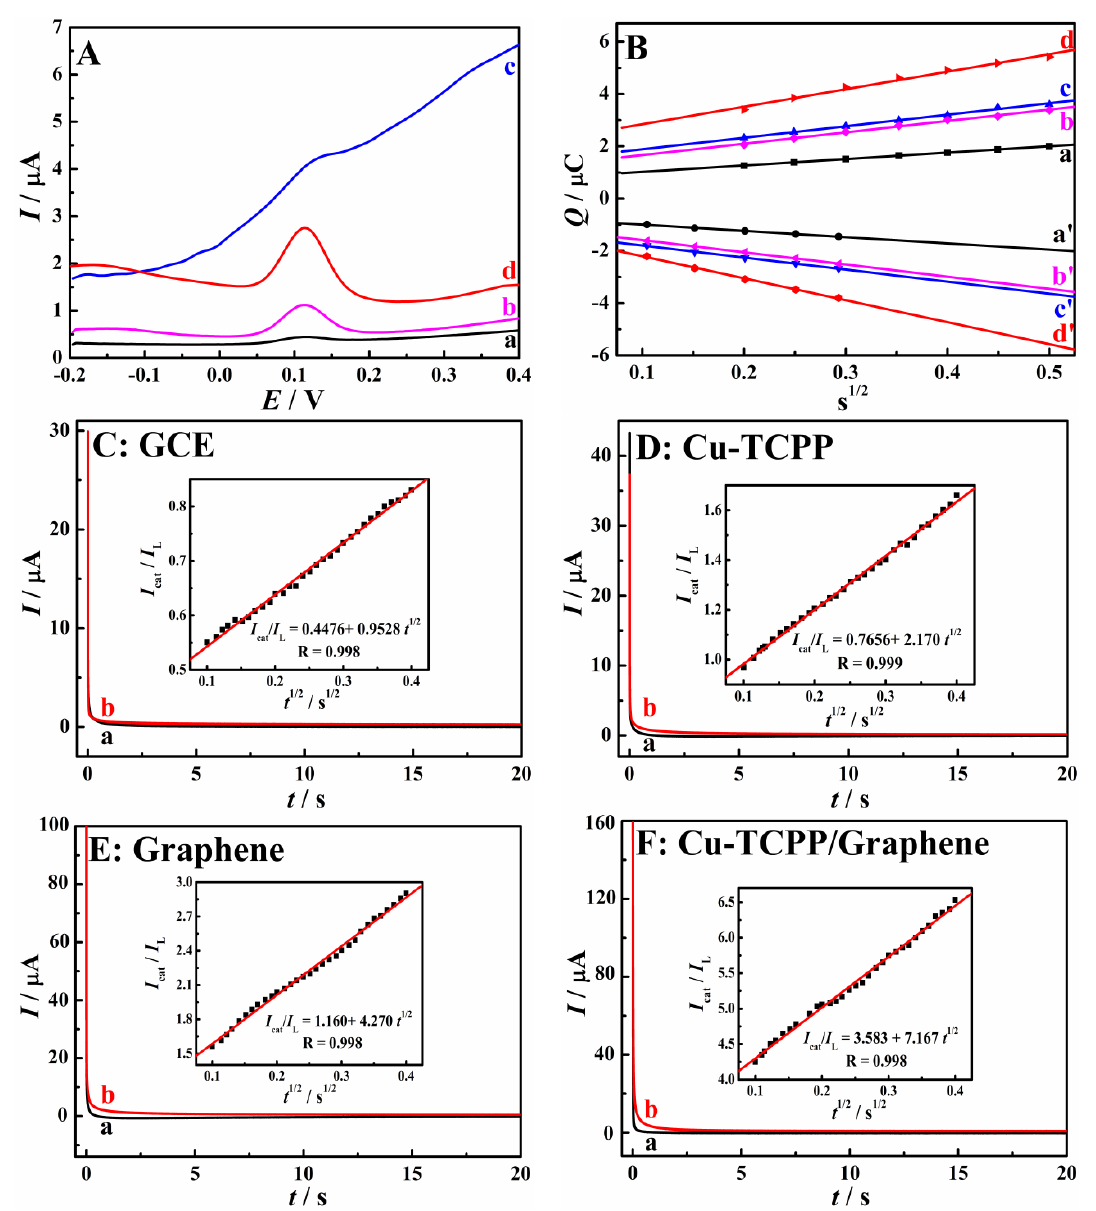
Figure 6. ( A ) DPV curves of 1 µM DA in pH 7.0 PBS on different GCEs; ( B ) plots of Q f vs. t 1/2 during the forward step (a–d) and Q r vs. f ( t ) during the reverse step (a′–d′) on GCE (a and a′), Cu-TCPP/GCE (b and b′), graphene (c and c′), and Cu-TCPP/graphene/GCE (d and d′); ( C – F ) chronoamperometry behaviors on different GCEs in the absence (a) or presence of 1 mM DA in pH 7.0 PBS, inset: plots of I cat / I L - t 1/2 .